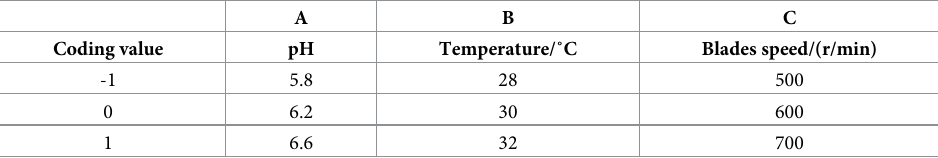
Table 1. Independent variables and levels in Box-Behnken